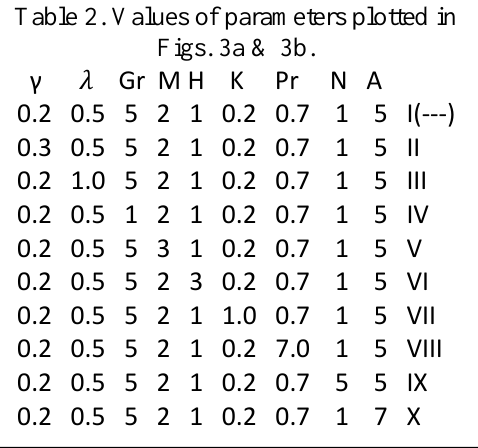
Table 2. Values of parameters plotted in Figs. 3a &